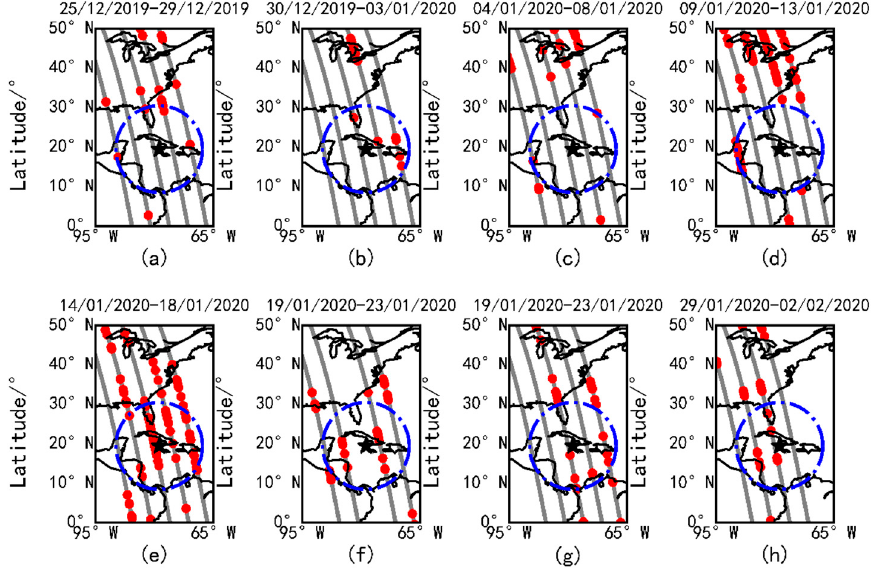
Figure 9. The spatial–temporal diagram of the abnormal disturbance of the Ex component in the ULF band (the black star represents the location of the epicenter, the blue circle represents the seis ‐ mogenic zone, and the red dot indicates the anomaly, In ( a – h ), it is shown that most of the anoma ‐ lies in the figure were concentrated in the area above the 40° N latitude during 35–15 days before the earthquake.).